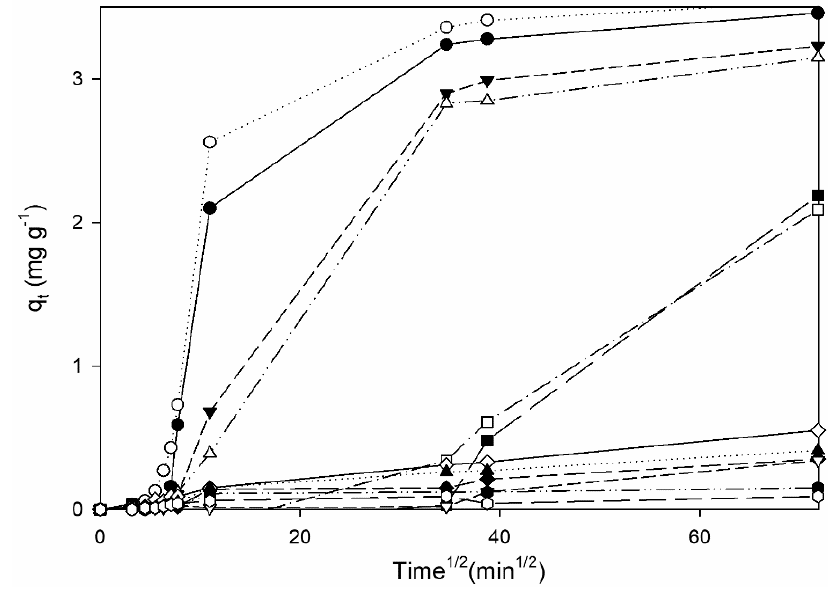
Table 5. Intra-particle diffusion data for different pH and two types of substrates.